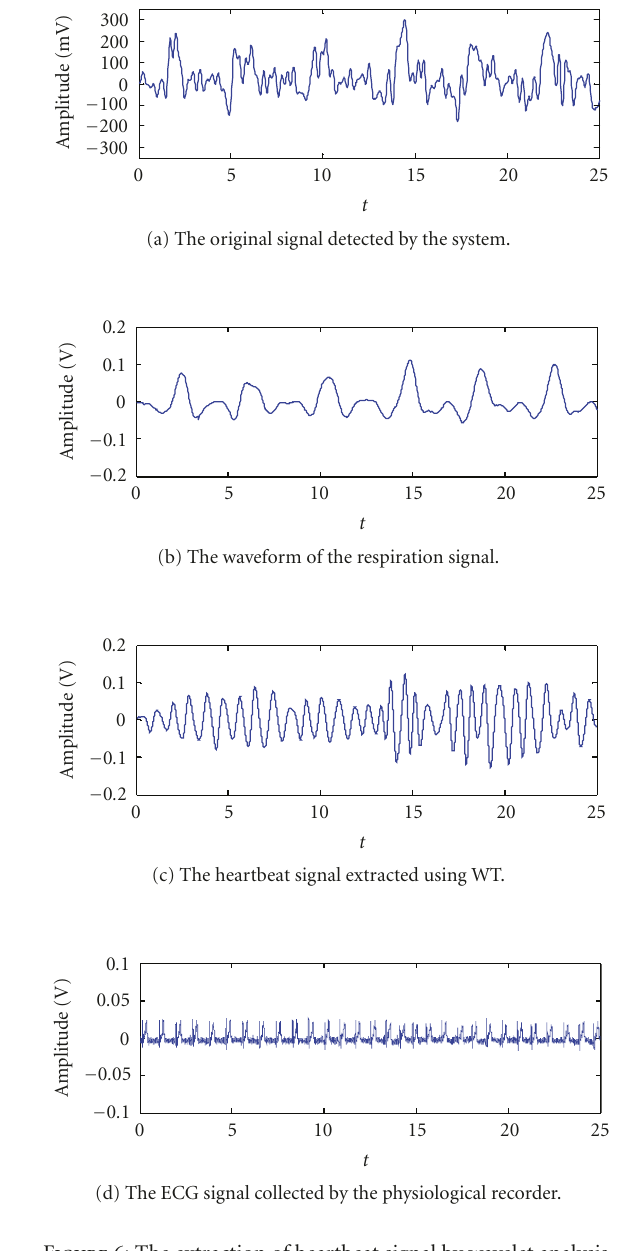
could not produce the ideal results. The wavelet transform technique is very sensitive to the frequency variation with higher resolution in time domain. With one-dimensional wavelet transform technique, the respiration signal and noise could be filtered e ffi ciently, and heartbeat signal can be ex- tracted with obvious frequency characteristics. More decom- position scales would be beneficial to the extraction of the heartbeat signal on the cost of increased computation bur- den. The optimal number of layers could be determined by